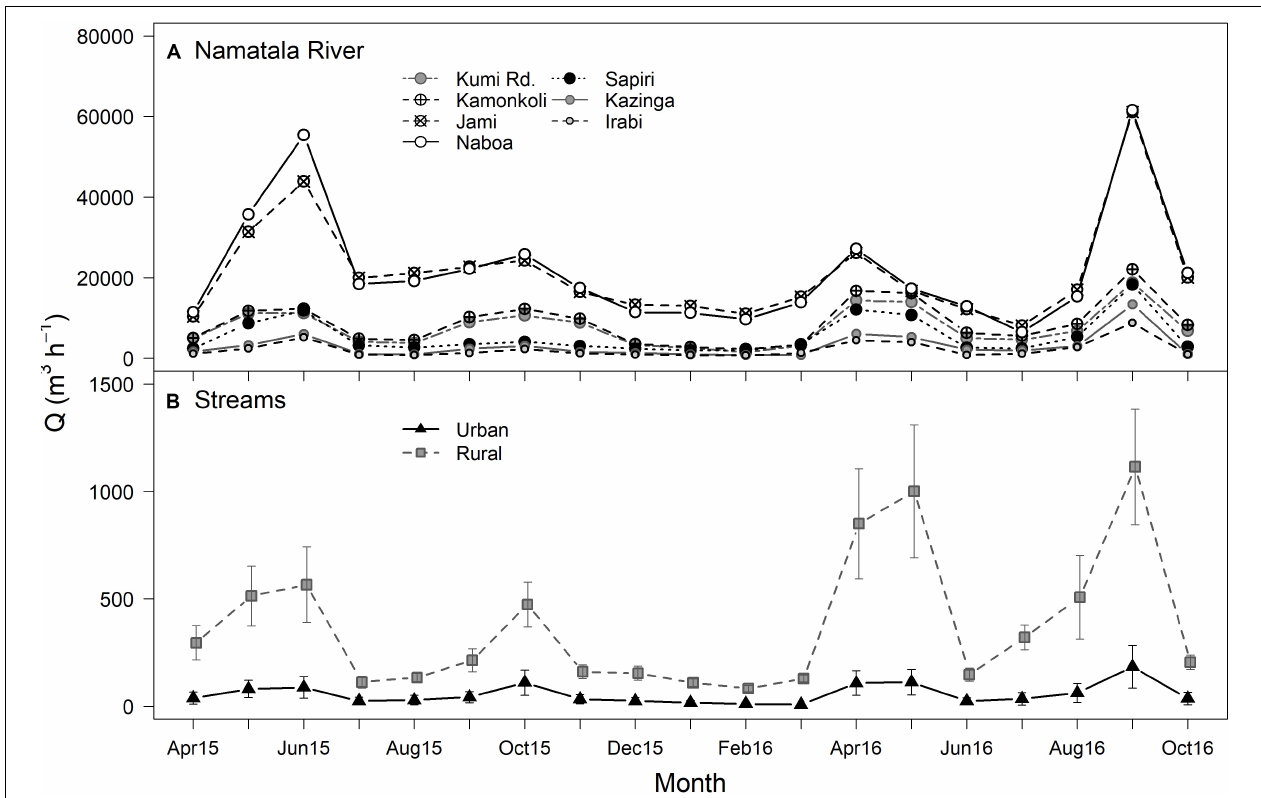
FIGURE 4 | Discharge in m 3 h − 1 measured monthly in Namatala Wetland for the period April 2015–October 2016, with (A) seven sampling points in Namatala River; and (B) mean values for the four urban streams ( n = 4) and three rural streams ( n = 3). Error bars indicate standard